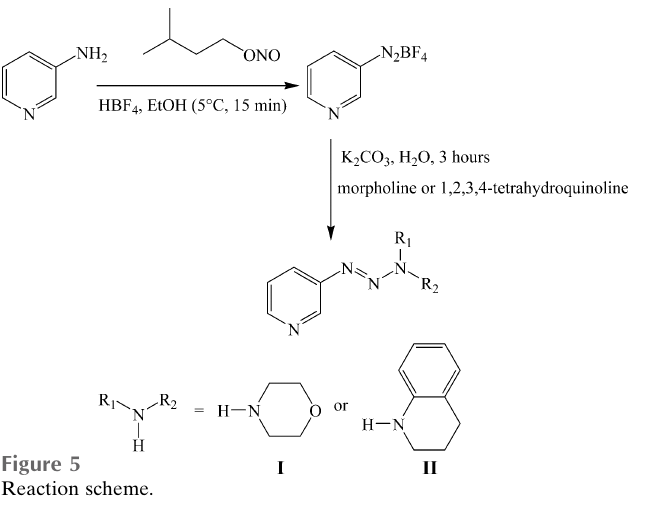
Figure 5 Reaction